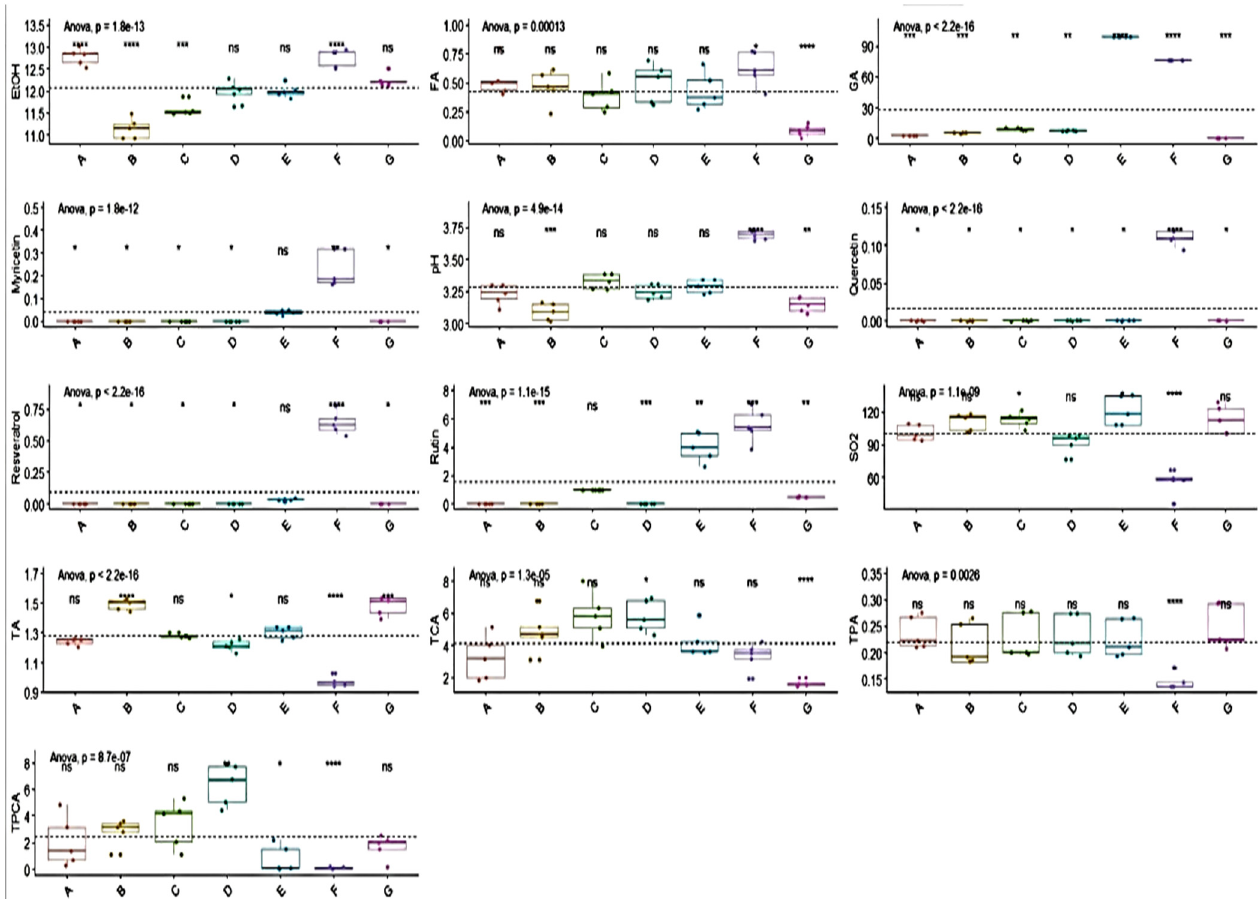
Figure 1. Oenological parameters and biologically active substances. TPA: total phenolic acid; SO2: total sulfur dioxide; EtOH: actual alcohol; TA: titratable acid. TCA: trans-caffeic acid; TPCA: trans-p-coumaric acid.